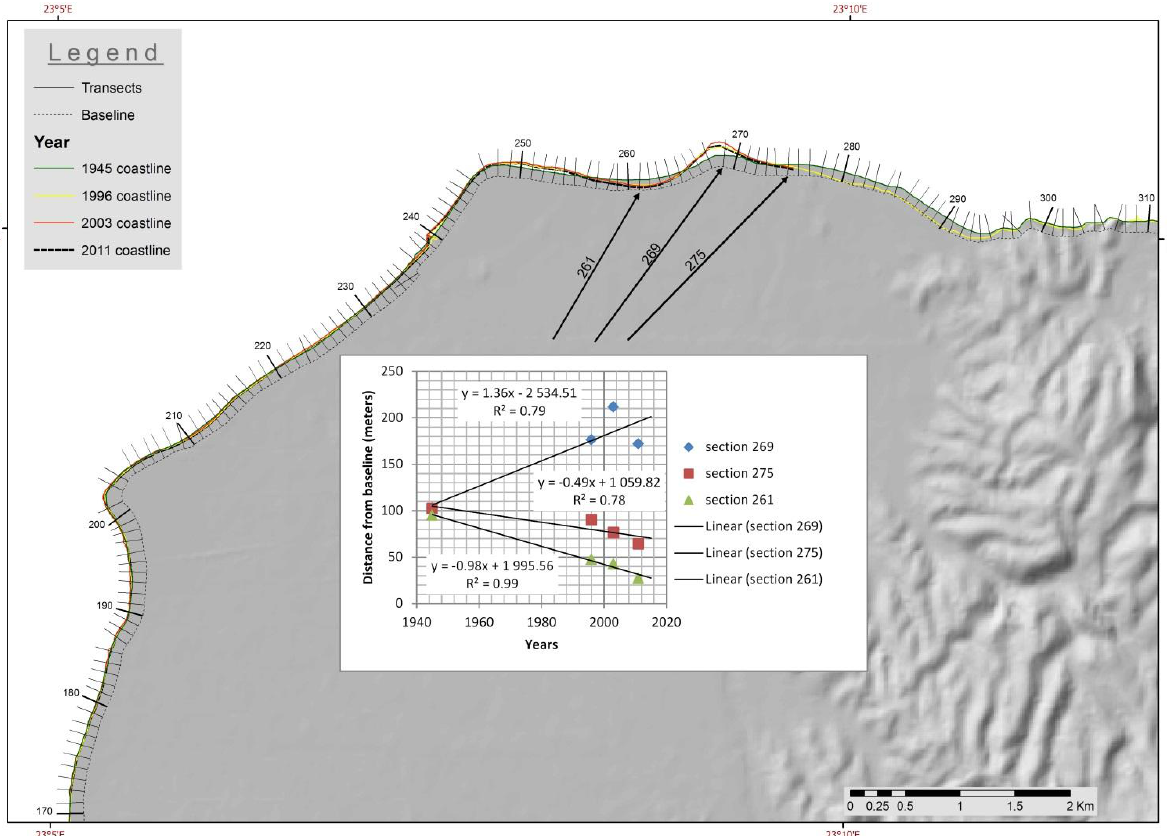
Figure 4. The calculation transects covered the entire deltaic fan area and the most hazardous segment due to coastal changes was identified at the contemporary estuary of the Xiropotamos River. The arrows indicate the three most representative sections, where either erosion (261, 275) or sediment deposition (269) are observed and the calculated rates are rather